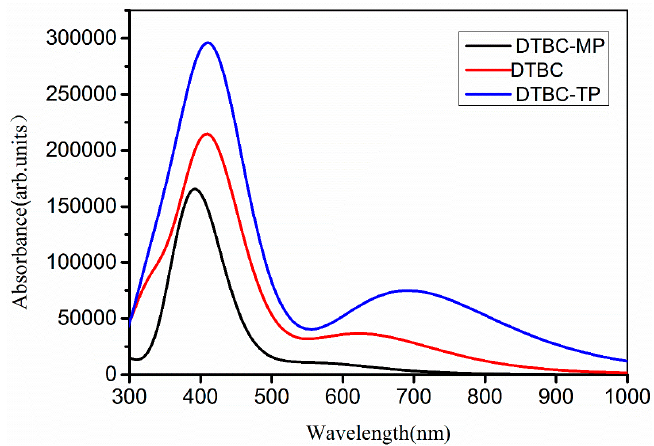
Figure 4. The simulated absorption spectra for DTBC-MP, DTBC and DTBC-TP based on time dependent density functional theory (TDDFT) calculated results with CAM-B3LYP/6-31G(d,p). The 0.333 eV of half-width at half-maximum was applied for absorption spectra simulations.